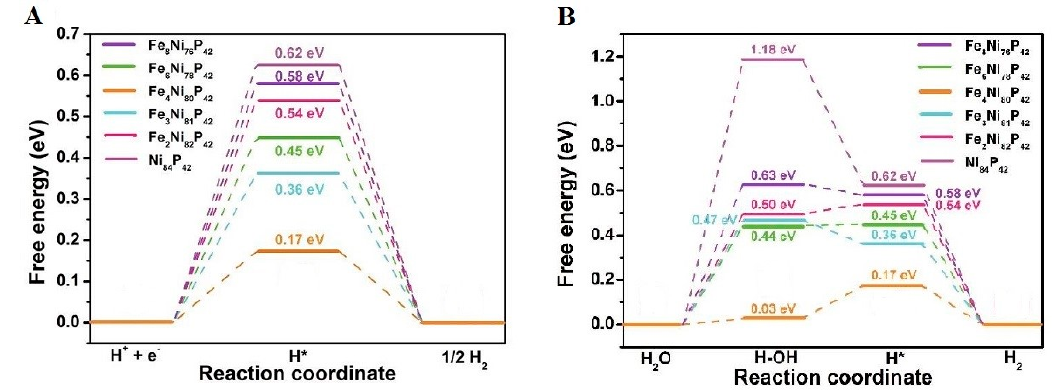
Figure 5. ( A ) Hydrogen adsorption free energy of Fe 8 Ni 76 P 42 , Fe 6 Ni 78 P 42 , Fe 4 Ni 80 P 42 , Fe 3 Ni 81 P 42 , Fe 2 Ni 82 P 42 , and Ni 84 P 42 in acidic HER with their P sites. ( B ) Water dissociation energy and hydrogen